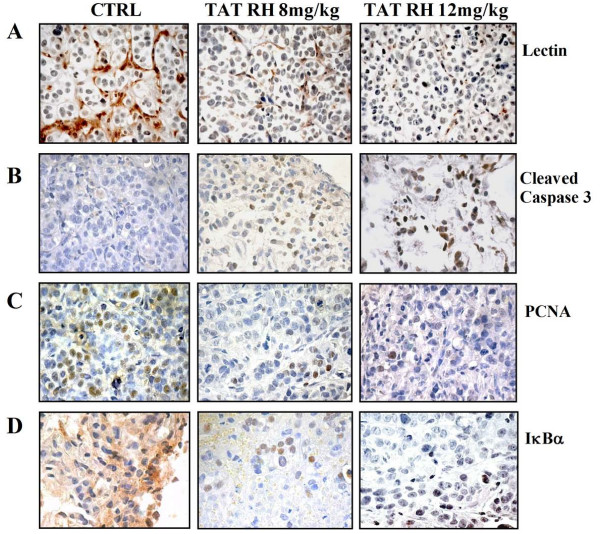
Histological analysis of TAT-RH treated tumors. Control and treated tumors were analized by histology. A) To evaluate angiogenesis in these tumors, lectin staining was used to visualize microvessels. TAT-RH reduces the formation of tumor vasculature. B and C) Cell death and proliferation were evaluated by analysis of cleaved caspase 3 and PCNA levels. TAT-RH treated tumors show increased cleaved caspase 3 levels (B) and reduced cell proliferation (C). D) We also evaluated IκBα subcellular localization. IκBα mainly localizes in the cytosol in control tumors while TAT-RH treatment causes its nuclear accumulation.